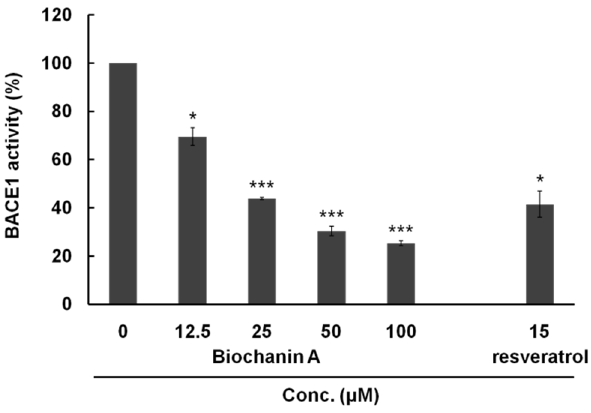
Figure 1. Concentration-dependent BACE1 inhibitory activity of biochanin A. Resveratrol was used as a positive control. Comparison of untreated and treated biochanin A is significantly different at * p < 0.05 and *** p < 0.001.